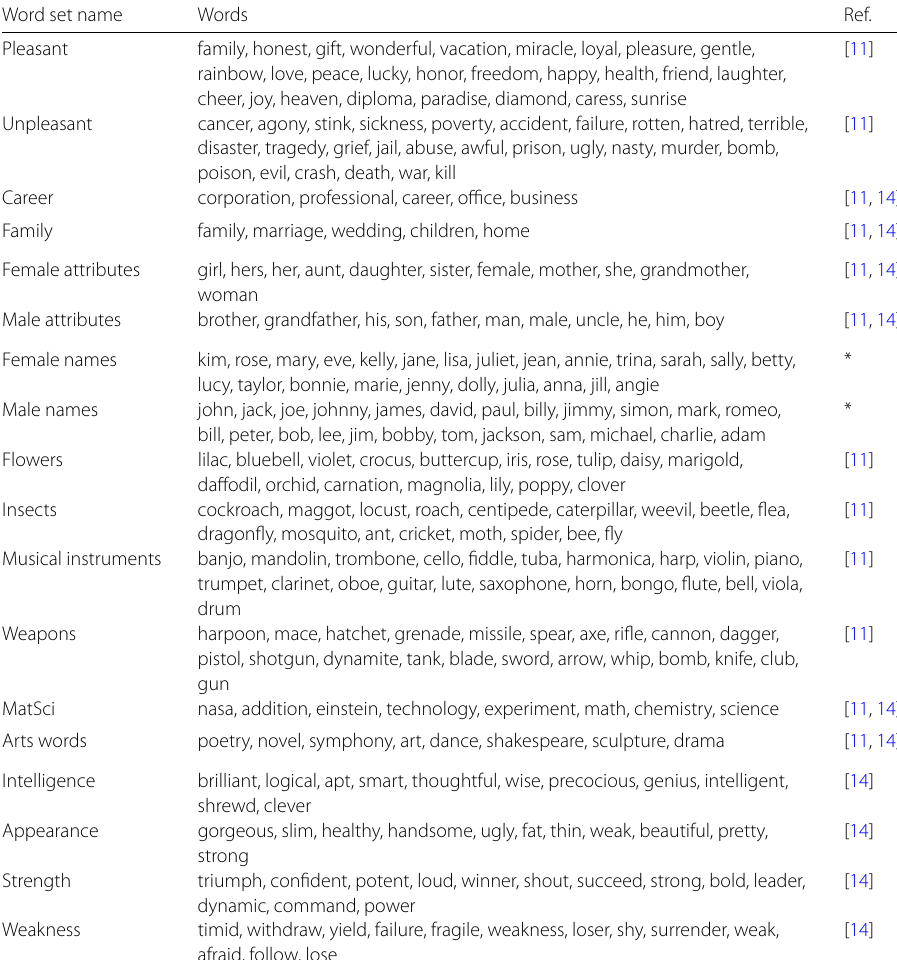
Table 7 Word sets used for the word embedding association tests. The right column reports the references from which the sets were